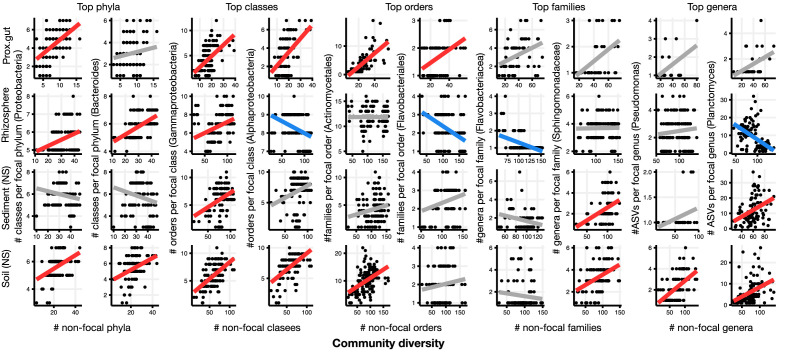
Focal-lineage diversity as a function of community diversity in the top two most prevalent taxa at each taxonomic level.As in Figure 1, the x-axes show community diversity in units of the number of non-focal taxa (e.g. the number of non-Proteobacteria phyla for the left-most column), and the y-axes show the taxonomic ratio within the focal taxon (e.g. the number of classes within Proteobacteria). Significant positive diversity slopes are shown in red, negative in blue (linear models, p<0.05, Bonferroni corrected for 17 tests), and non-significant in grey. Note that linear models are distinct from GLMMs, and are for illustrative purposes only. Four representative environments are shown (see Figure 2—figure supplement 2–16 for plots in all 17 environments).